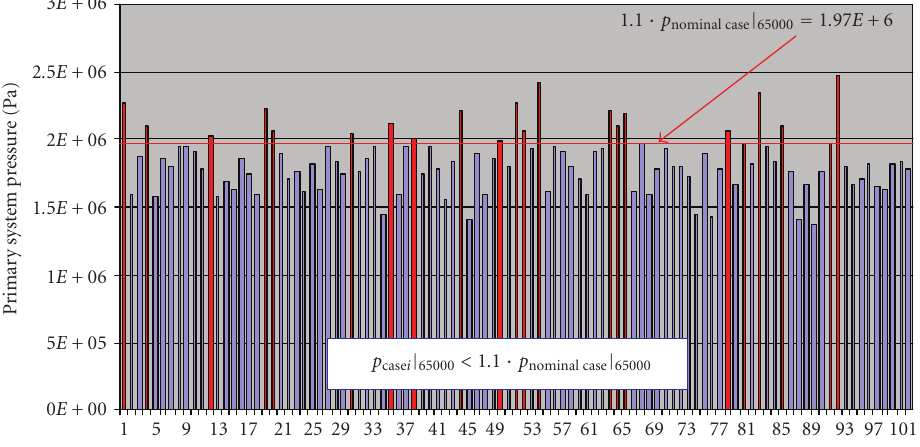
Figure 11: Transient performance indicator—3 results (long term).